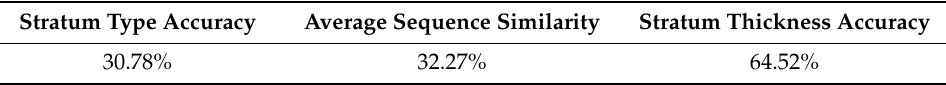
Table 11. Statistics of 3D geological model prediction results.